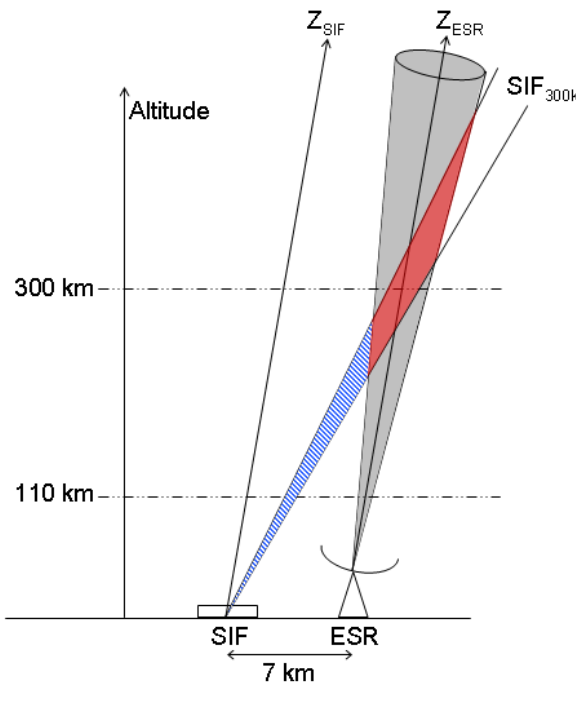
Fig. 3. Representation of the viewing geometry used in this study. The emission volumes observed by the two imagers at the Auroral Station site are compared to the scattering volume illuminated by the ESR